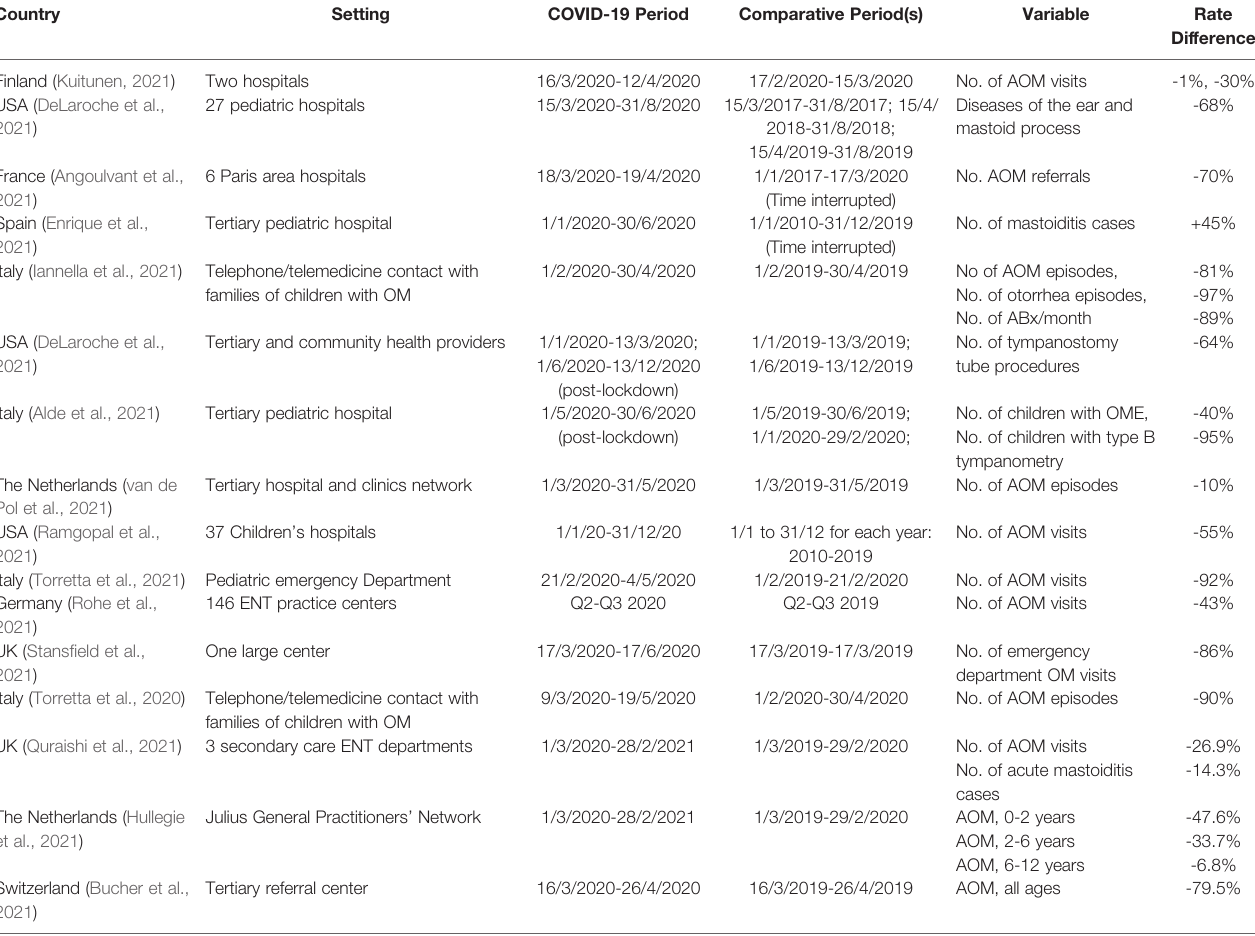
TABLE 2 | Reduction in otitis media burden during COVID-19